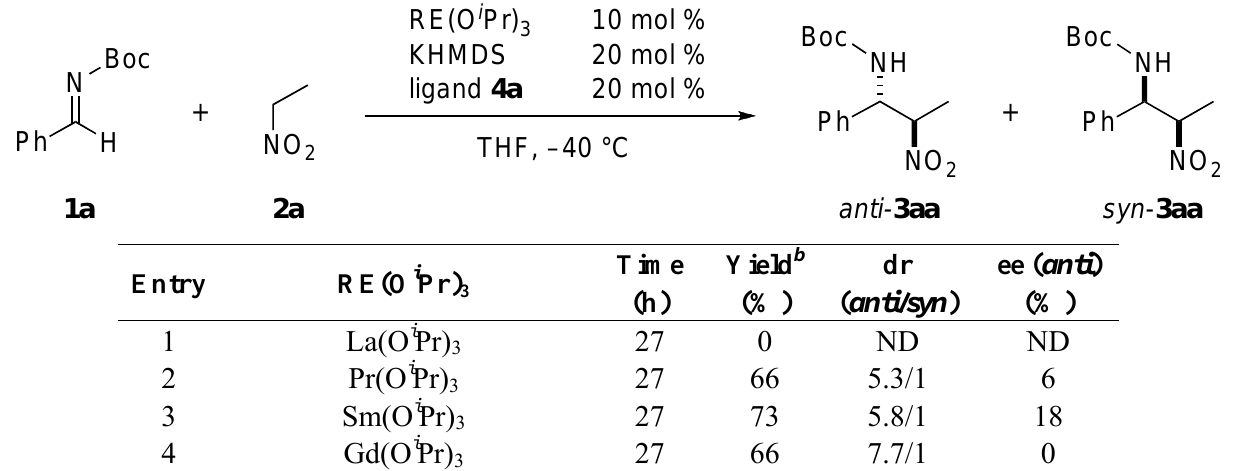
Table 2. Catalytic asymmetric nitro-Mannich reaction promoted by RE/K/ 4a heterobimetallic catalyst.